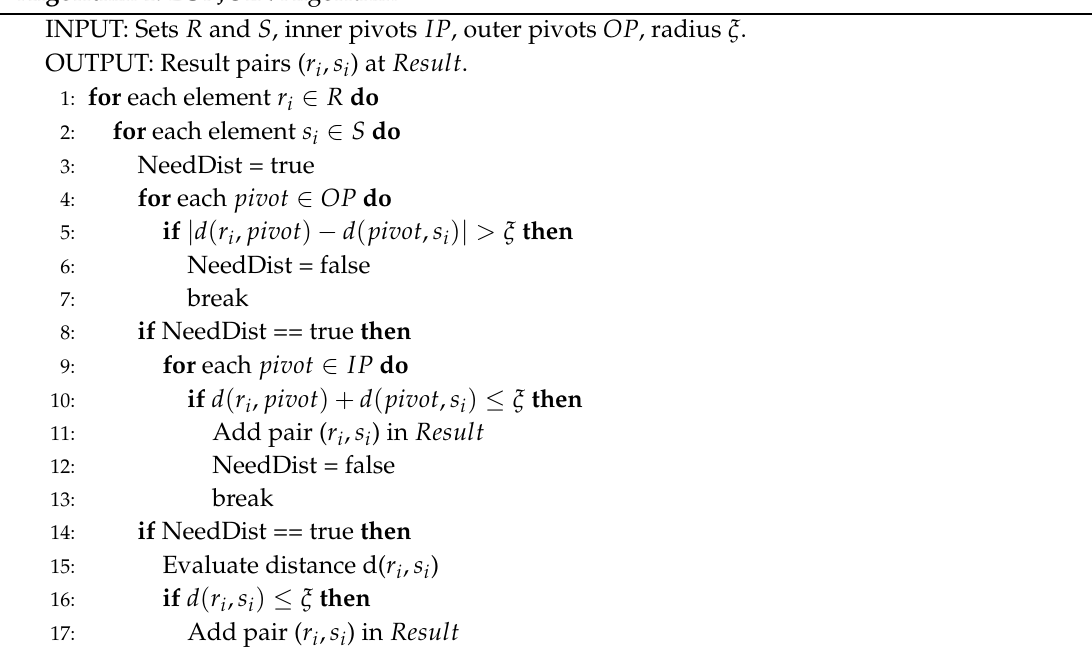
Algorithm 1: LUBJOIN